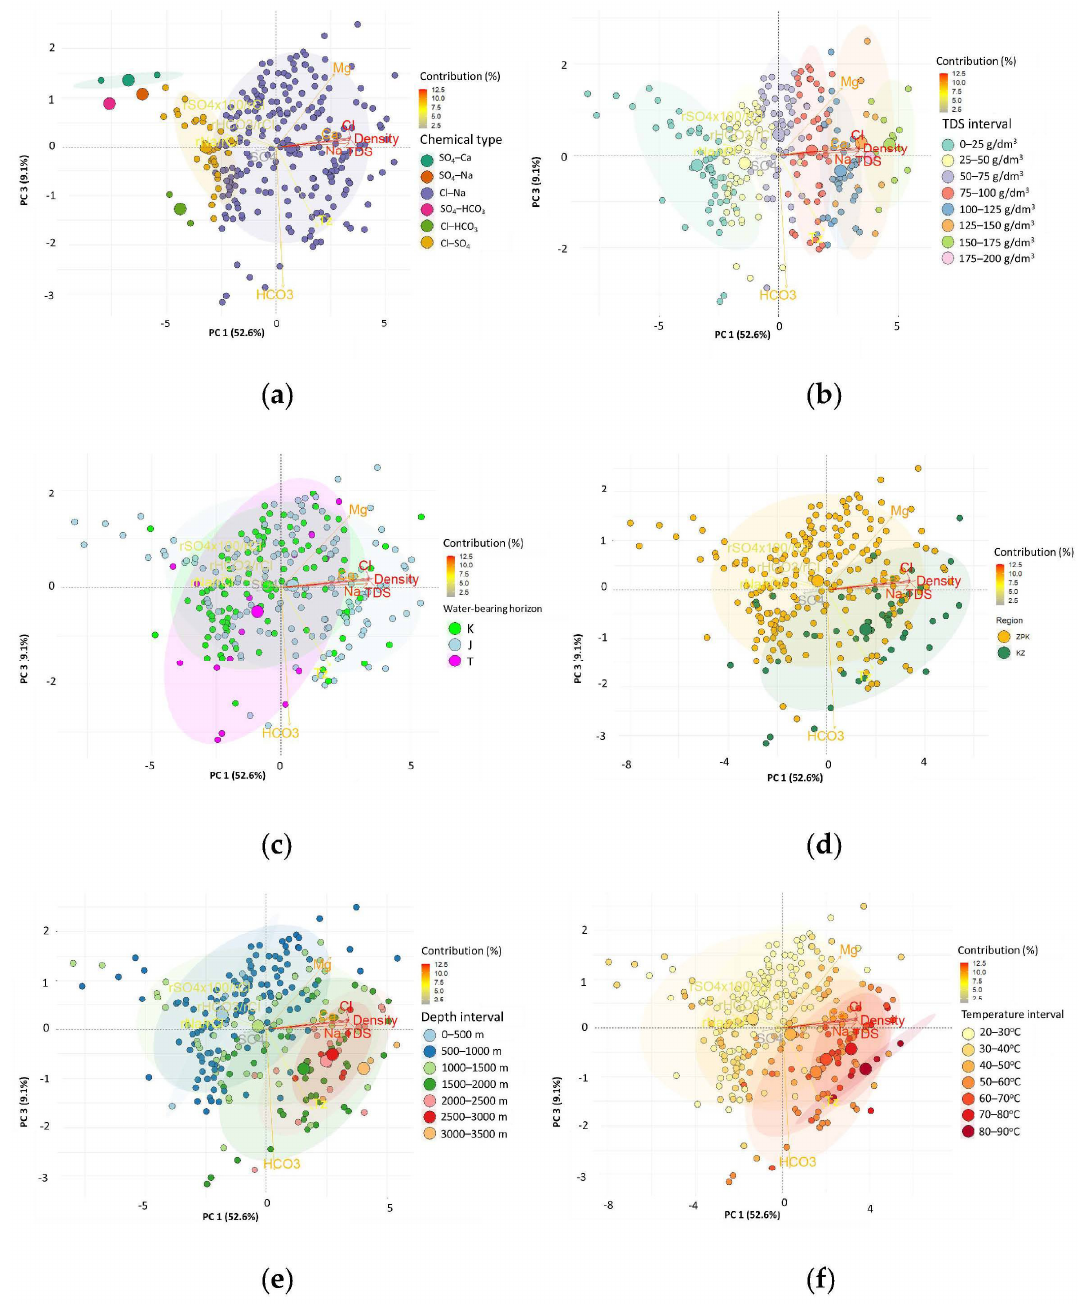
Figure 10. Biplot of factor coordinates for the cases and variables as a result of the Principal Component Analysis on the surface of PC 1 and PC 3, on the background of: ( a ) the chemical type of the water; ( b ) TDS of the water; ( c ) water-bearing horizon; ( d ) region; ( e ) depth; and ( f ) estimated temperature